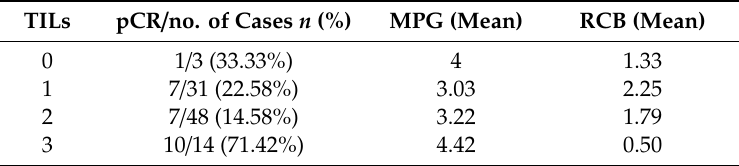
Table 4. Tumoral response to chemotherapy according to TILs